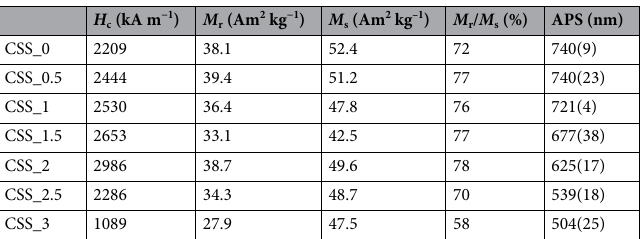
Table 1. Significant magnetic properties extracted from hysteresis loops (Fig. 5b): saturation mass magnetization ( M s ), remanent mass magnetization ( M r ), coercivity ( H c ), and M r / M s